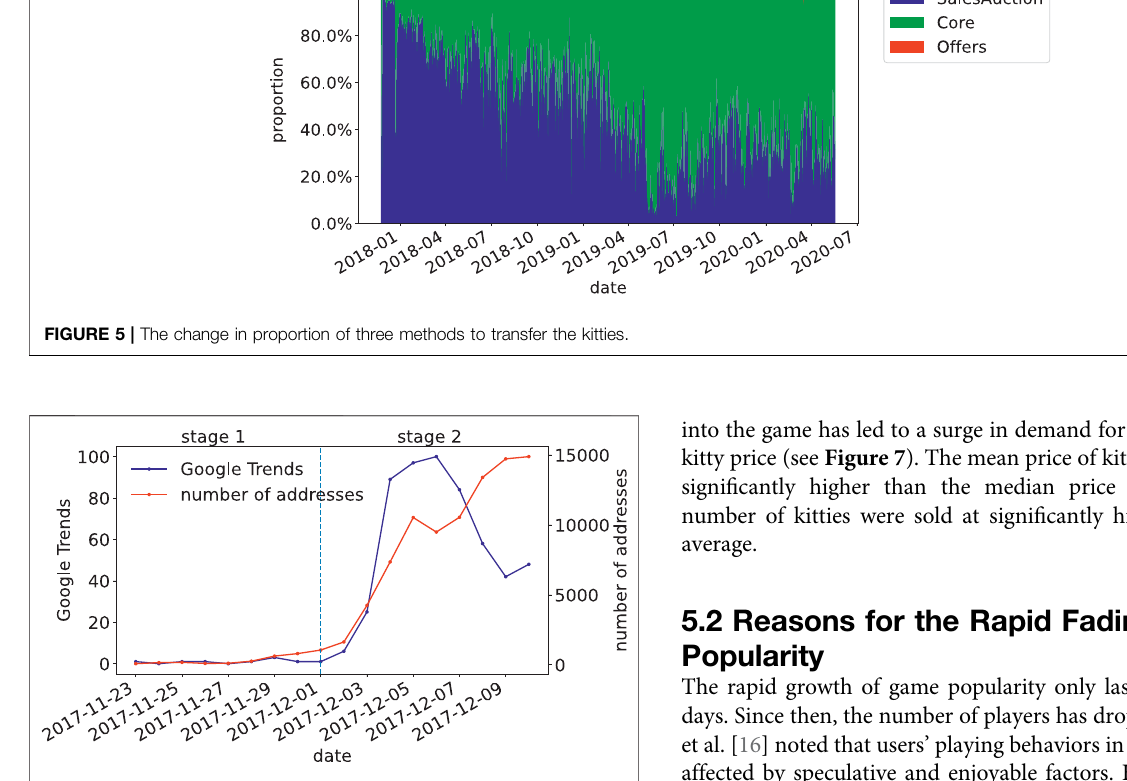
FIGURE 6 | Google Trends of CryptoKitties and the numbers of daily active addresses.